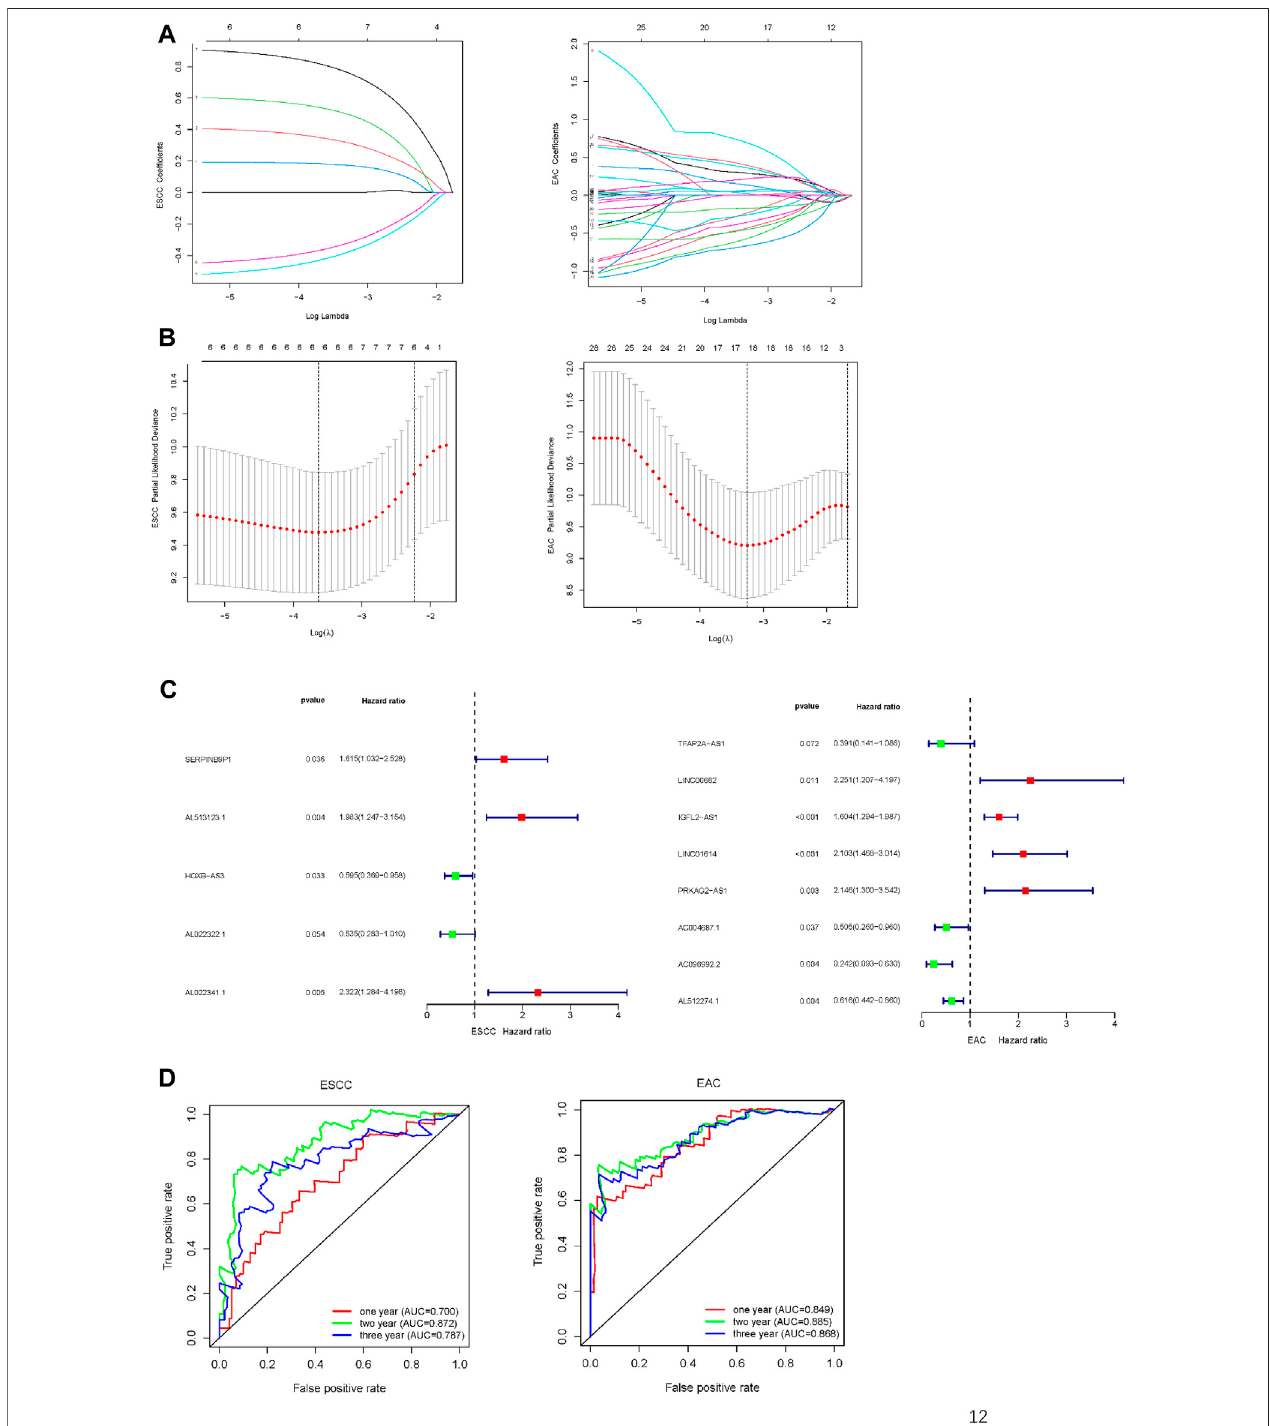
FIGURE 4 | Construction of the prognostic immune-related multi-lncRNA risk model in ESCC and EAC. (A) Lasso regression coef fi cient pro fi les of the prognostic lncRNA in ESCC and EAC. (B) Optimal and minimum criterion of Lasso penalization parameter ( λ ) used 10-fold cross-validation in ESCC and EAC cohorts. (C) Multi- lncRNA prognostic signatures in ESCC and EAC. (D) ROC curve of 1-, 2-, and 3-years overall survival for validating the capacity of predicting prognosis of the risk models. (E) Kaplan – Meiersurvival analyses in “ High-risk ” and “ Low-risk ” groups ofESCCand EAC. (F) ExpressionlevelofthelncRNAandpatients ’ survivalstatus in risk models of ESCC and EAC. (G) Principal component analysis (PCA) in patients of “ High-risk ” and “ Low-risk ” groups based on the immune-related lncRNA of risk models in ESCC and EAC. ROC, receiver operating characteristic. AUC, area under curve.